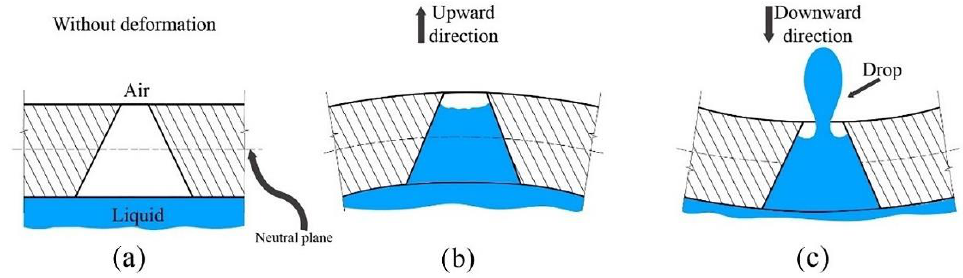
Figure 10. Dynamic deformation of a micro-aperture with a conical shape, ( a ) prior to deformation, ( b ) with deformation in upward direction, and ( c ) downward direction.